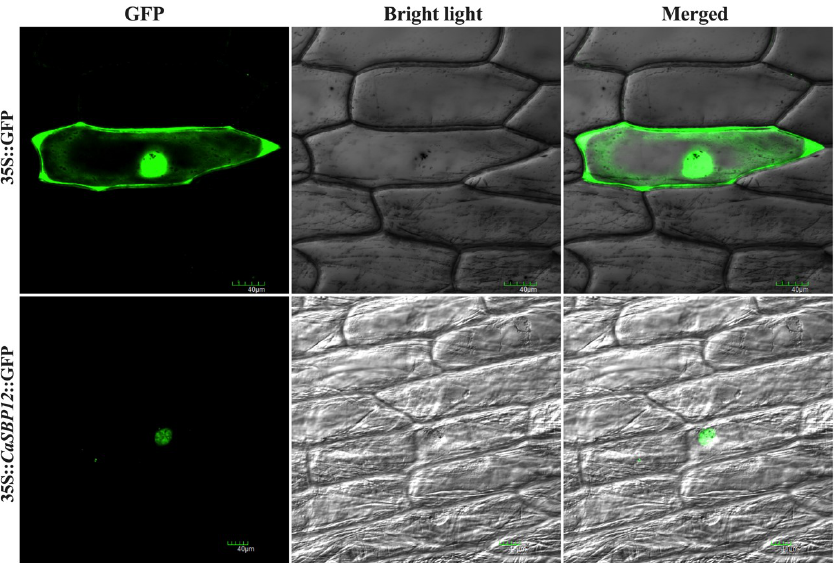
Figure 1. Subcellular localization of the CaSBP12 protein. Transient expression of 35S::GFP, 35S:: CaSBP12 ::GFP in onion epidermal cells via particle bombardment. The fluorescence was visualized using a laser scanning confocal microscope under bright and fluorescence fields. The photographs were taken in a dark field for green fluorescence and under bright light for the morphology of the cell. Bars in this picture are 40 µ m.